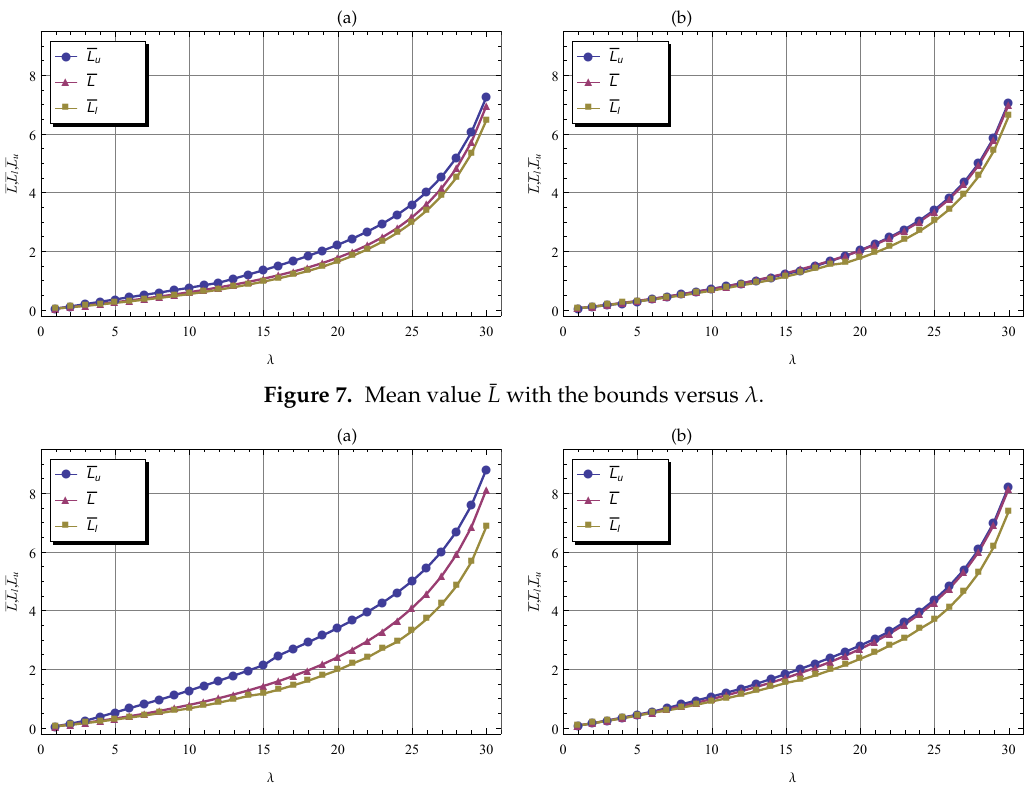
Figure 8. Mean value ¯ L with the bounds versus λ